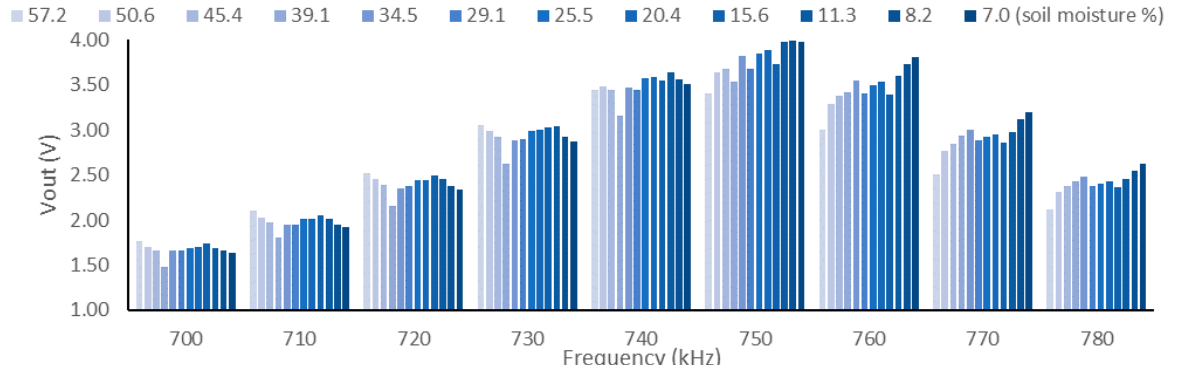
Figure 23. The Vout in the different frequencies tested in the prototype NP1.